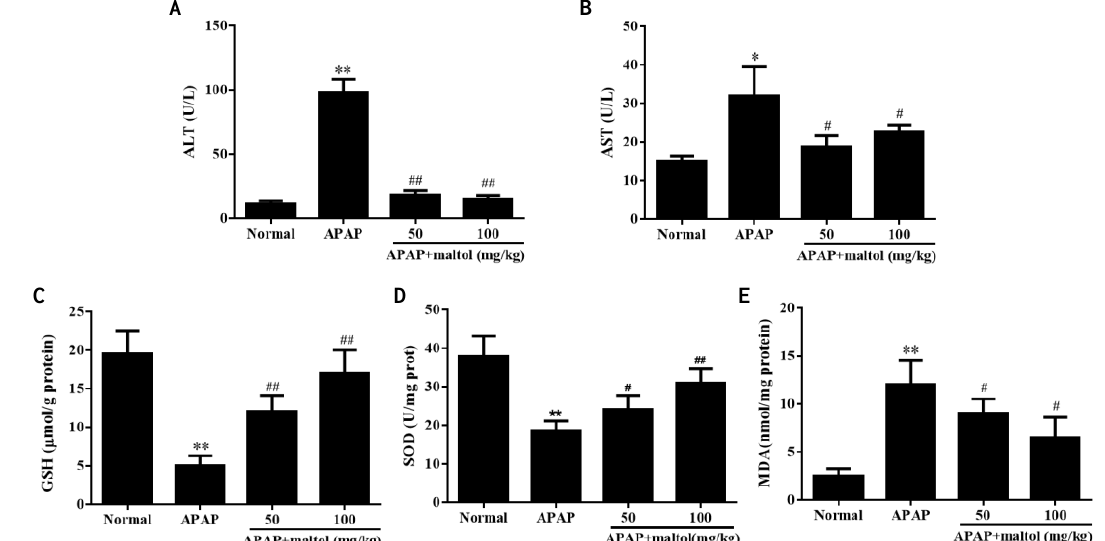
Figure 1. Effects of maltol pretreatment on hepatic dysfunction and histopathological changes caused by an overdose of acetaminophen (APAP). ( A ) serum alanine aminotransferase (ALT) and ( B ) aspartate aminotransferase (AST) activities; ( C ) liver glutathione (GSH) and ( D ) superoxide dismutase (SOD) amount; ( E ) liver malondialdehyde (MDA) content. All data were expressed as mean ± S.D; n = 8, * p < 0.05, ** p < 0.01, vs normal group; # p < 0.05, ## p < 0.01 vs APAP group.